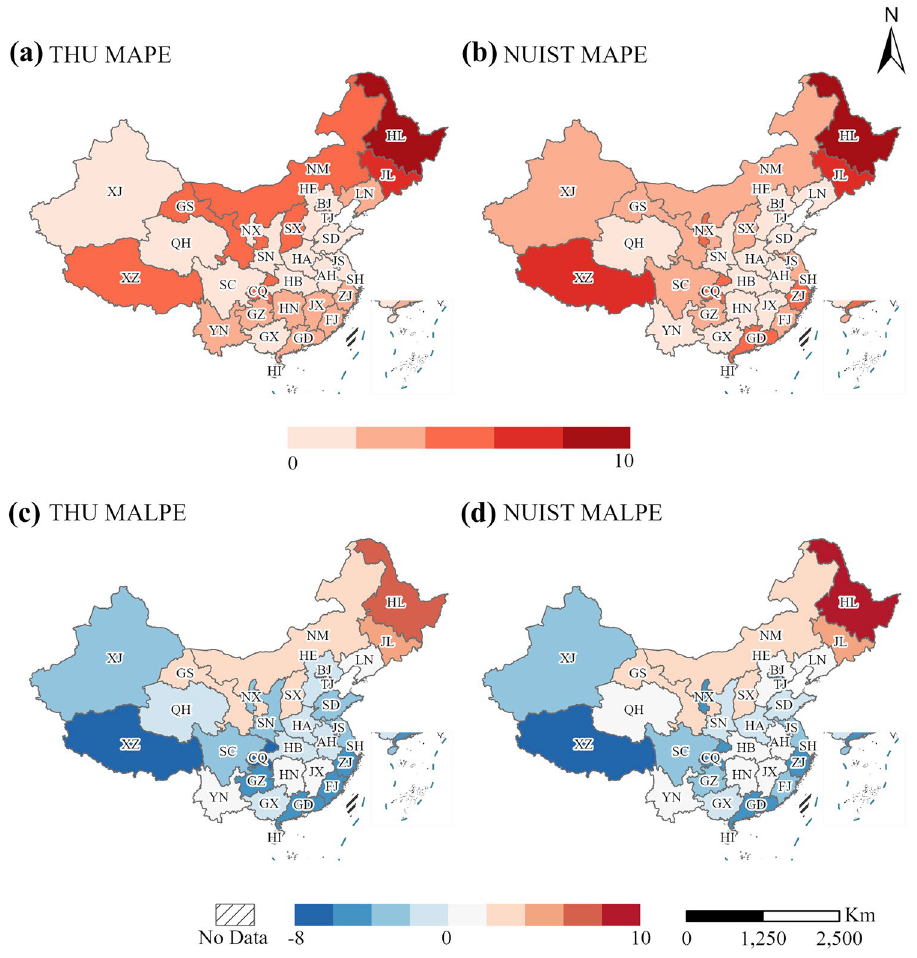
Figure 4. Distribution of the provincial MAPE and MALPE of NUIST and THU. The left panel ( a , c ) shows the THU results, and the right panel ( b , d ) shows the NUIST results.